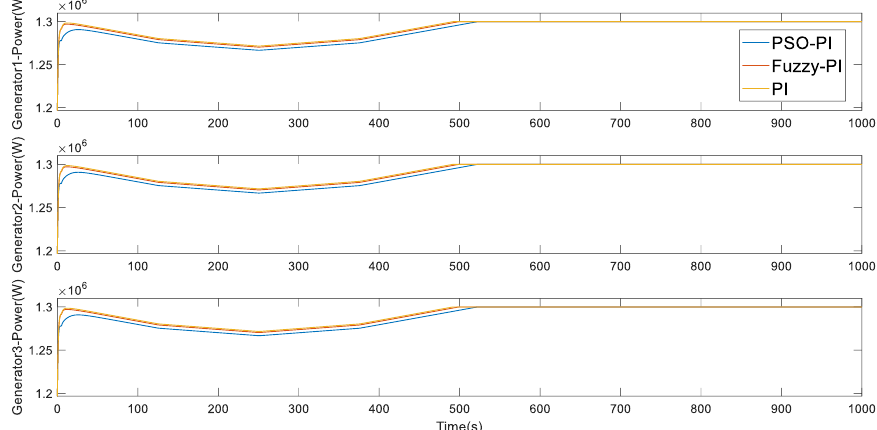
Figure 23. Output power of diesel generator in Example 2.